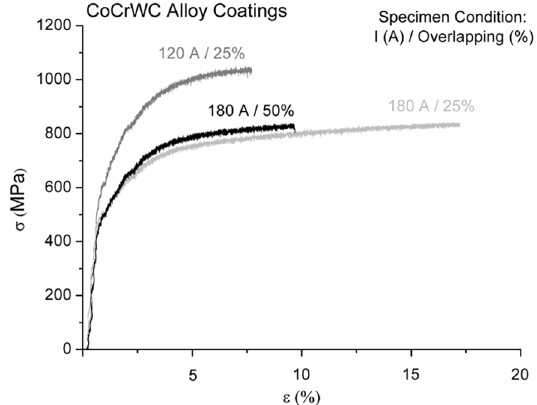
Figure 14. Typical tensile testing curves of the coatings. Table 6. Summary of the tensile results with standard deviation